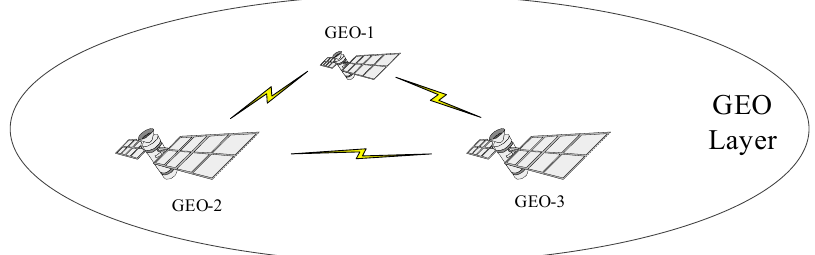
Figure 1. Composition structure of the geostationary earth orbit (GEO) layer satellite system.